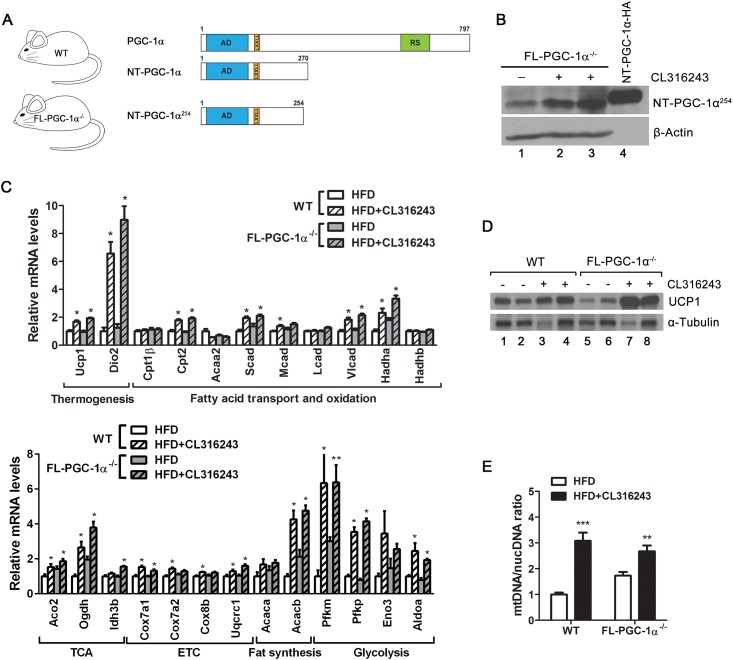
Gene expression changes in FL-PGC-1α-/- brown adipose tissue in response to CL316243.(A) Schematic diagram of WT mice expressing PGC-1α and NT-PGC-1α and of FL-PGC-1α-/- mice only expressing NT-PGC-1α254. AD, transcription activation domain; LxxLL, nuclear receptor interaction motif; RS, arginine/serine-rich domain. At the age of 9 to 10 weeks, WT and FL-PGC-1α-/- mice (n = 8 per group) were singly housed and provided a high-fat diet (HFD) ad libitum for 2 weeks, followed by the same diet containing 0.001% CL316243 (HFD + CL316243) for 6 days. (B) Increased expression of NT-PGC-1α254 by β3-AR activation in FL-PGC-1α-/- BAT. NT-PGC-1α-HA in HEK293 cells was used as a positive control. (C) Quantitative real-time PCR analysis of a number of metabolic genes in WT and FL-PGC-1α-/- BAT (n = 7–8 per group). HFD vs HFD+CL316243: *P < 0.05, **P < 0.01. (D) Protein levels of UCP1 in BAT whole cell extracts. Identical amounts of proteins were loaded, and α-tubulin was used as a loading control. (E) Quantitative analysis of mitochondrial biogenesis. The ratio of mitochondrial DNA (mtDNA) relative to nuclear genome (nucDNA) was analyzed in BAT (n = 7–8 per group). **P < 0.01, ***P < 0.001.